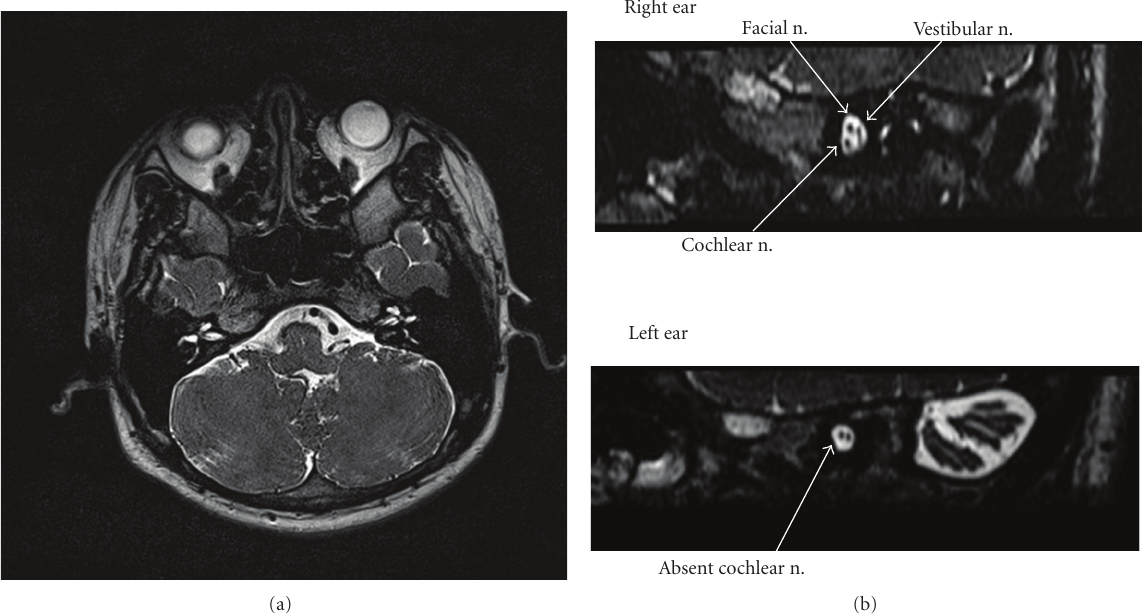
Figure 1: Axial 3-dimensional T2-weighted images through the internal auditory canal of case 1. The reconstructed sagittal oblique images were demonstrated. The right ear has a normal-size cochlear nerve as marked by arrow, while the left cochlear nerve is absent although facial nerve and vestibular nerve have their distinguishable locations.